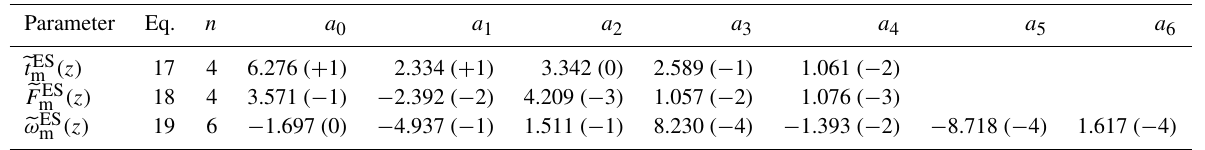
Table 3. Coefficients of the polynomial expansion P n parentheses should be read as powers of